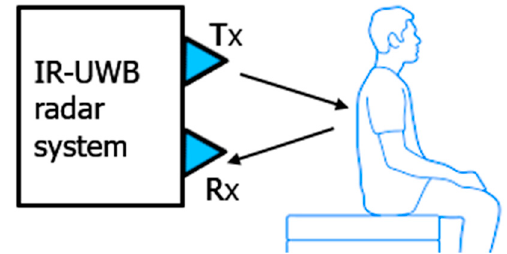
Figure 11. Experimental setup for data acquisition.